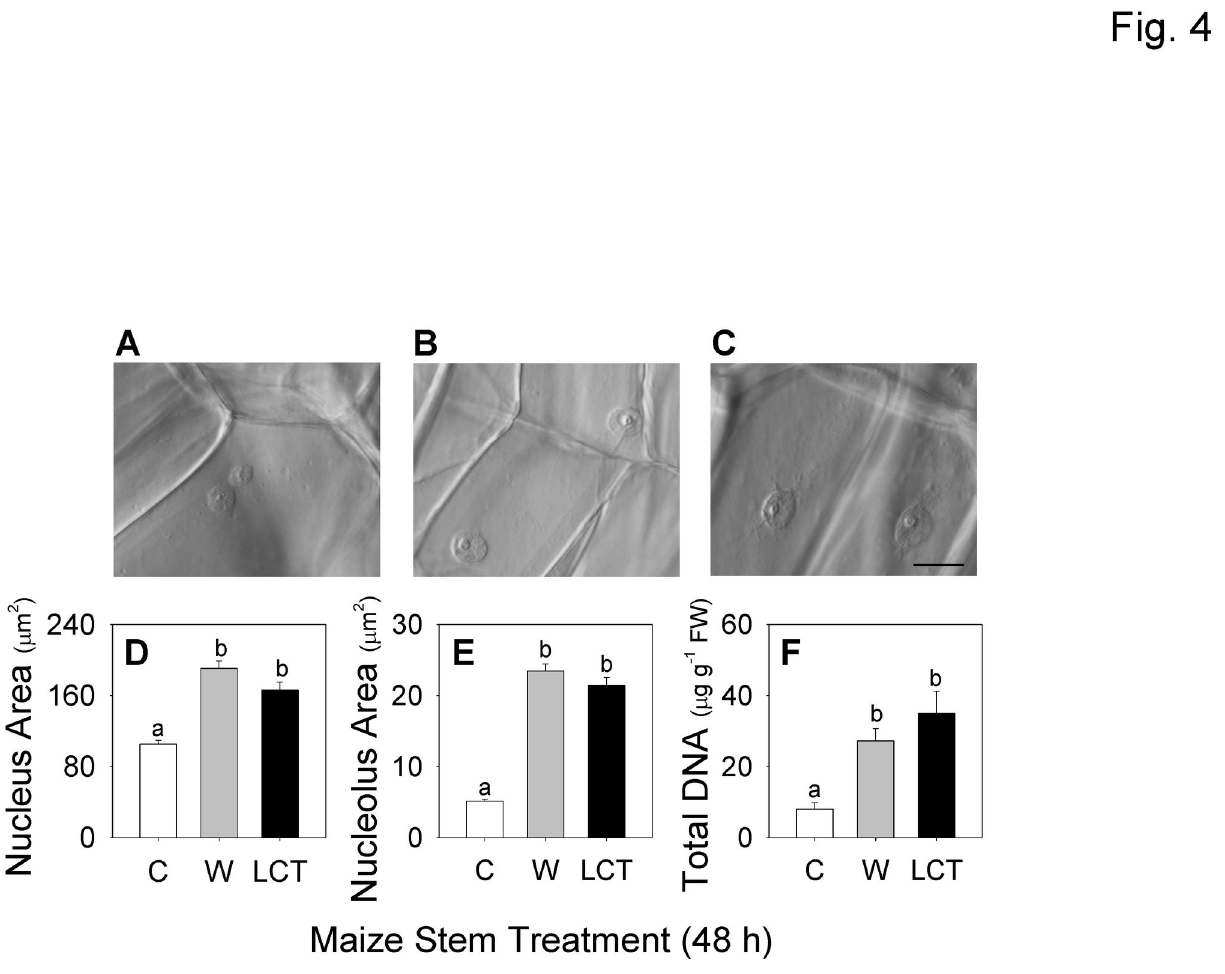
Figure 4. Consistent with maize endoreduplication, both wounding and ECB stem herbivory treatments promote significant increases both nuclear and nucleolar size as well as total DNA levels. Light microscopy pictures of nuclei and nucleoli from representative A , control (C), B , wounded (W) and C , larval-conditioned tissues (LCT). Scale bar = 20 µm. Average areas ( n = 40, ±SEM) of D , nuclei and E , nucleoli and F , concentration of total DNA ( n = 3, +SEM). Different letters (a–b) represent significant differences (all ANOVAs P < 0.01; Tukey test corrections for multiple comparisons, P < 0.05). doi: possible due to the lack of a reliable internal standard and did not occur after wounding alone. Consistent with this rapid interference from non-specific staining of cell walls by dynamic, LCT exhibits 3.5-fold greater IAA levels than fluorescent DNA stains. However, consistent with predictions wounding alone, even after 48 h (Figure 5A). Surprisingly, a for endoreduplication, total extractable DNA content was also screen for candidate small molecule effectors in ECB OS approximately 4-fold greater after wound and LCT treatments revealed exceedingly high levels of free IAA. ECB OS from compared to untreated control tissues (Figure 4F). larvae supplied with leaf and stem tissue displayed IAA concentrations of 800 and 50 µg ml -1 , respectively (Figure 5B). Levels of IAA in freshly collected frass samples from larvae provided leaf and stem diets were also greatly elevated (Figure 5B). In air-dried frass samples, levels of IAA were not statistically different than those in leaf OS. The average ( n = 3) quantity of IAA in dry frass samples originating from leaf and stem diets is 951 ± 382 µg g -1 and 872 ± 582 µg g -1 , respectively.